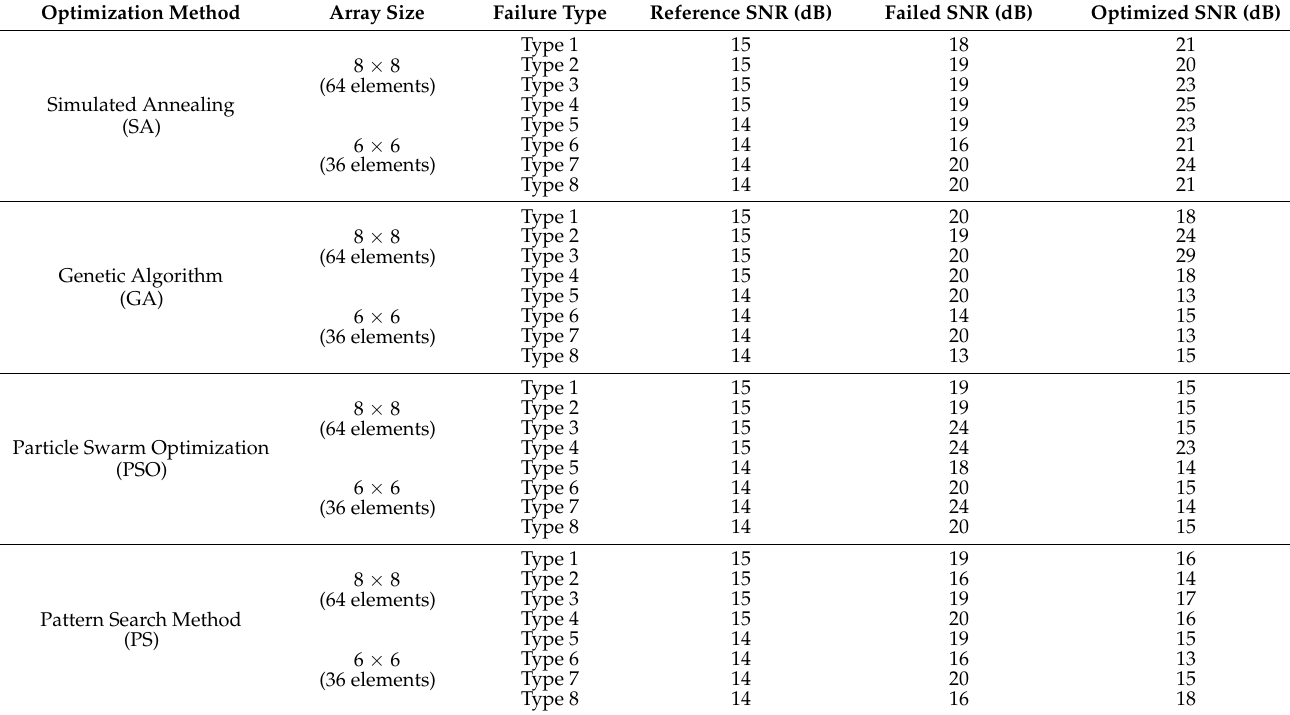
Table 7. Results of various types of failures for four different optimization methods of 8 × 8 and 6 × 6 planar arrays. Optimization